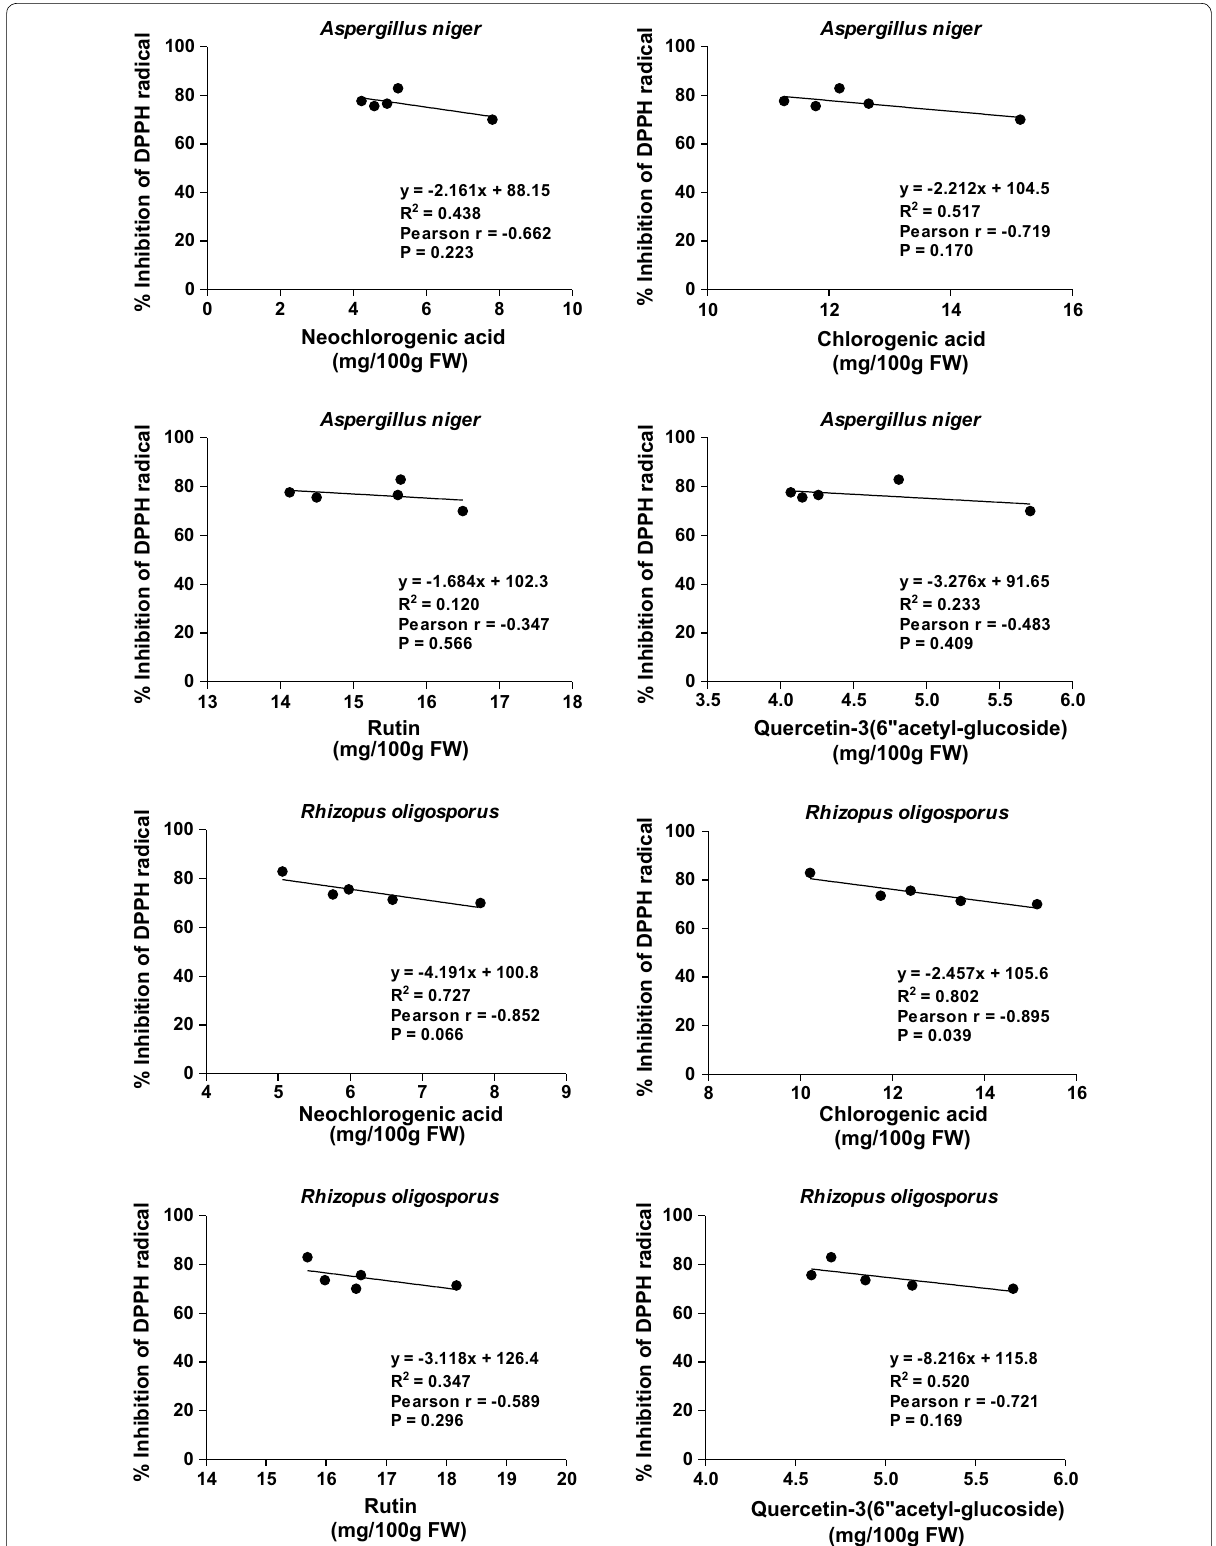
Fig. 6 Correlation coefficients between antioxidant activity (DPPH) and the main individual phenolics in the extracts of solid‑state fermented apricot press